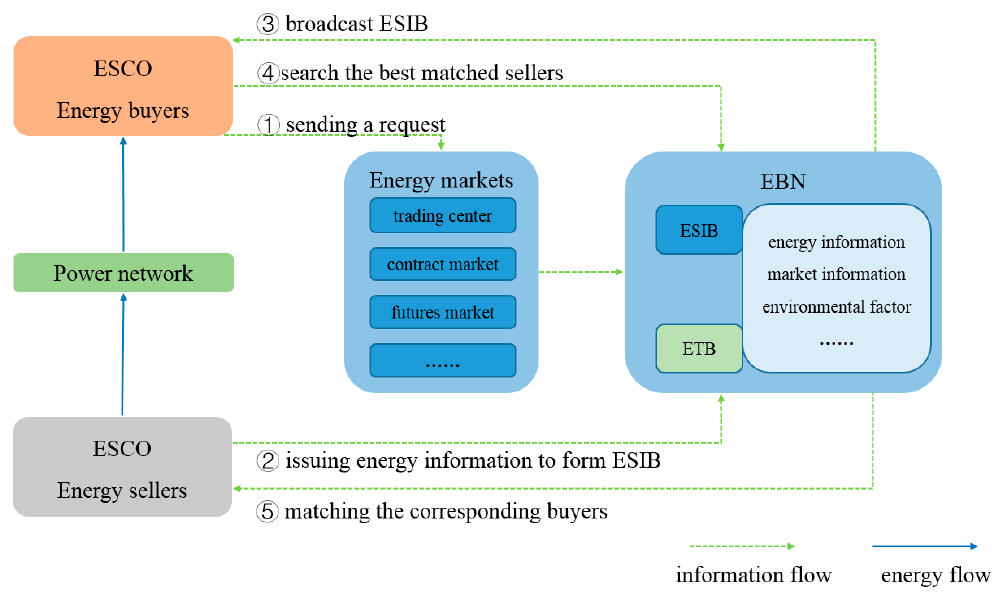
Figure 4. Individual ESCO model based on EBN (EBN ‐ IESCOM) operational process.